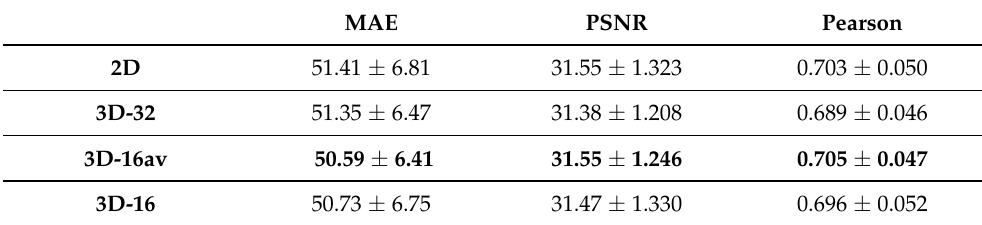
Table 18. Pelvis dataset with Residual-net. Mean Absolute Error, PSNR and Pearson coefficient from Residual-net using different convolutions and reconstructions in the Pelvis data set.